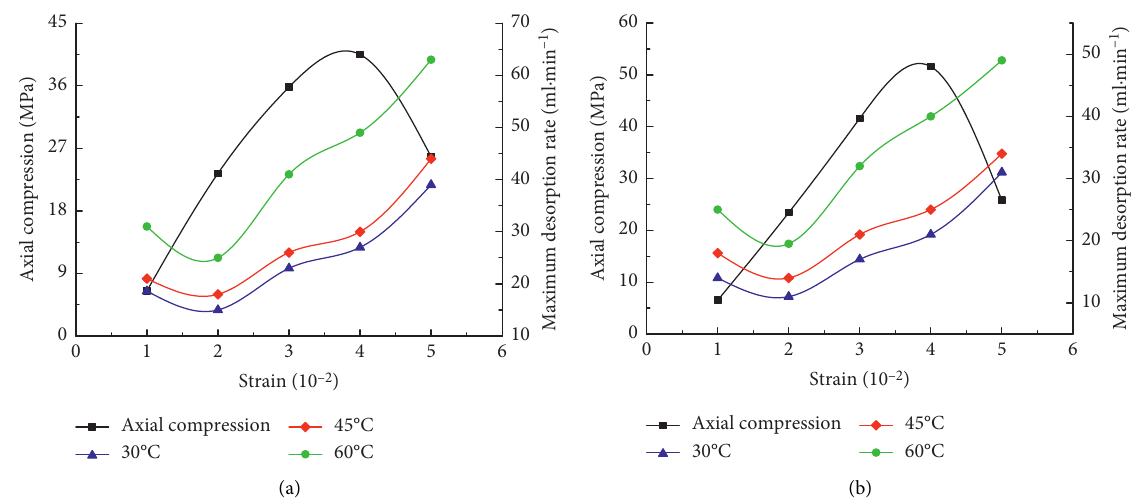
Figure 15: Relation curve between stress-strain and desorption rate under the confining pressure of (a) 3MPa and (b) 5MPa.